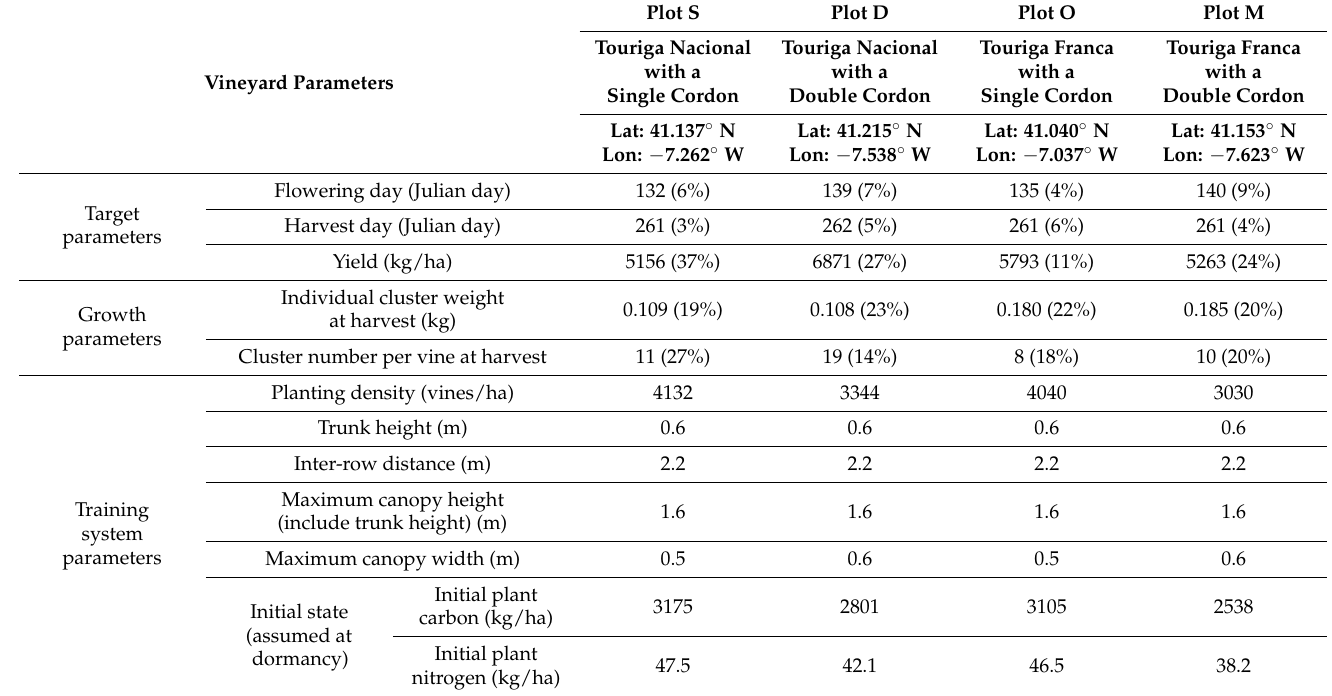
Table 1. Summary of the measured parameters in the four experimental vineyard plots from 2014 to 2019. The indicated figures and the figures in the brackets (where applicable) are the mean and the coefficient variation (CV) of the 6-year measurements in each plot, respectively. The yearly values for the measured cluster weight and cluster number per vine at harvest are taken from the median of the measurements over 20 random replicates (vines) at each plot (refer to Table S1 for more details). Note the measured individual harvestable cluster weight (kg) is independent from the training system, and mainly determined by variety. The training system parameters are mostly empirically determined according to a local expert ´ s